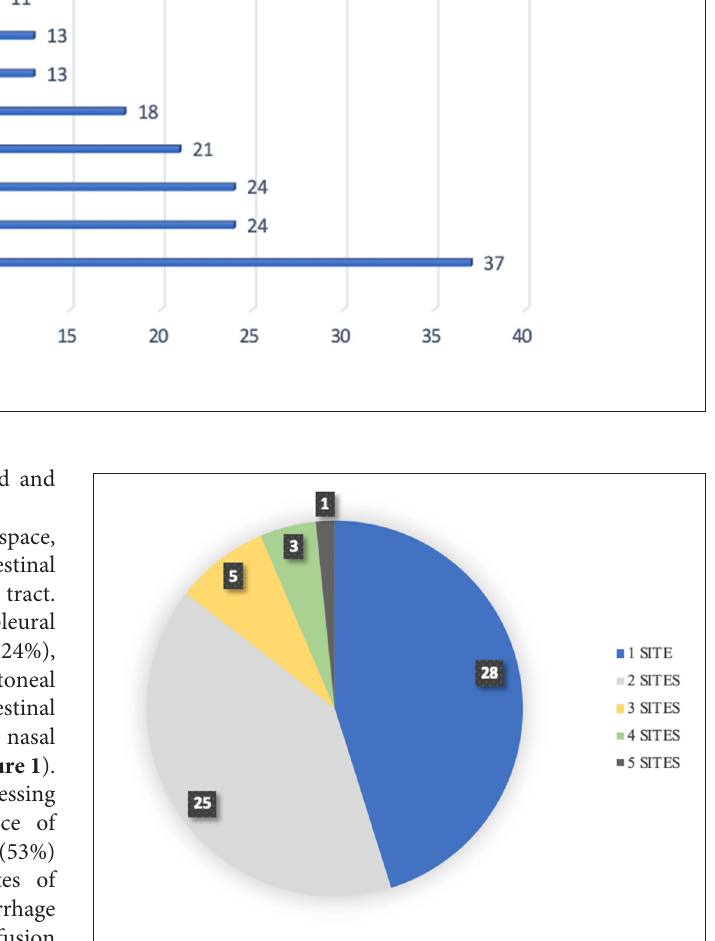
FIGURE 2 | Sites of